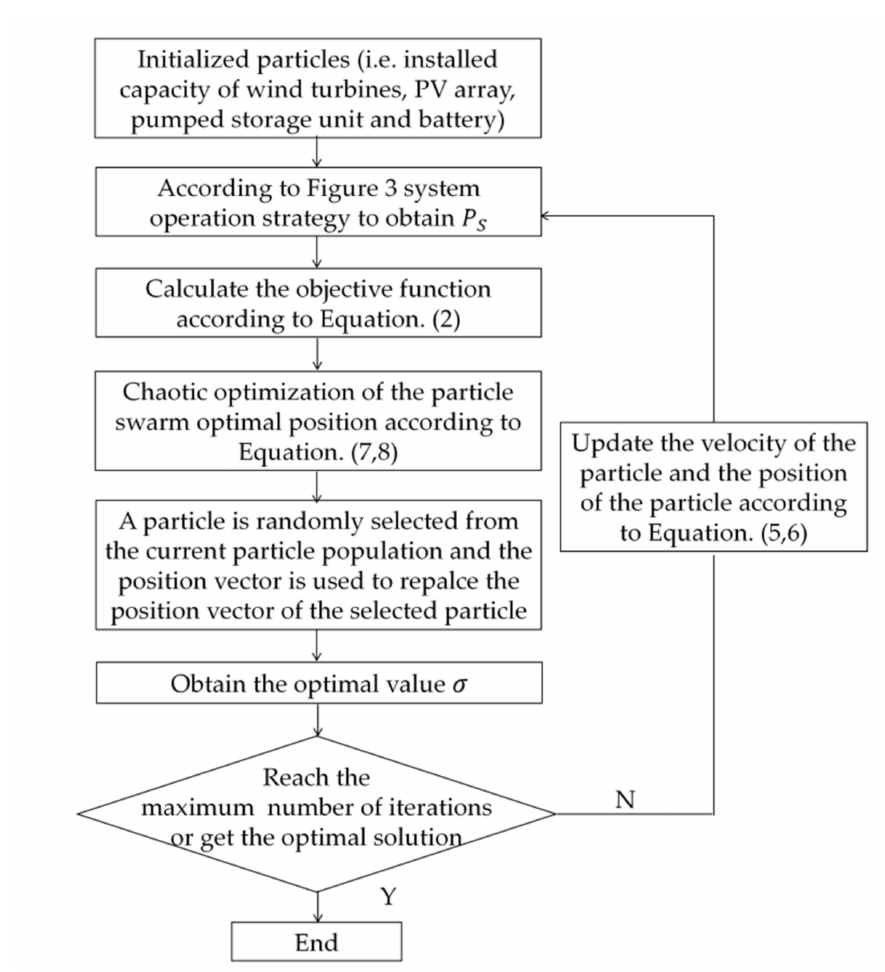
Figure 4. Application of the CPSO algorithm for the optimal operation of the hybrid